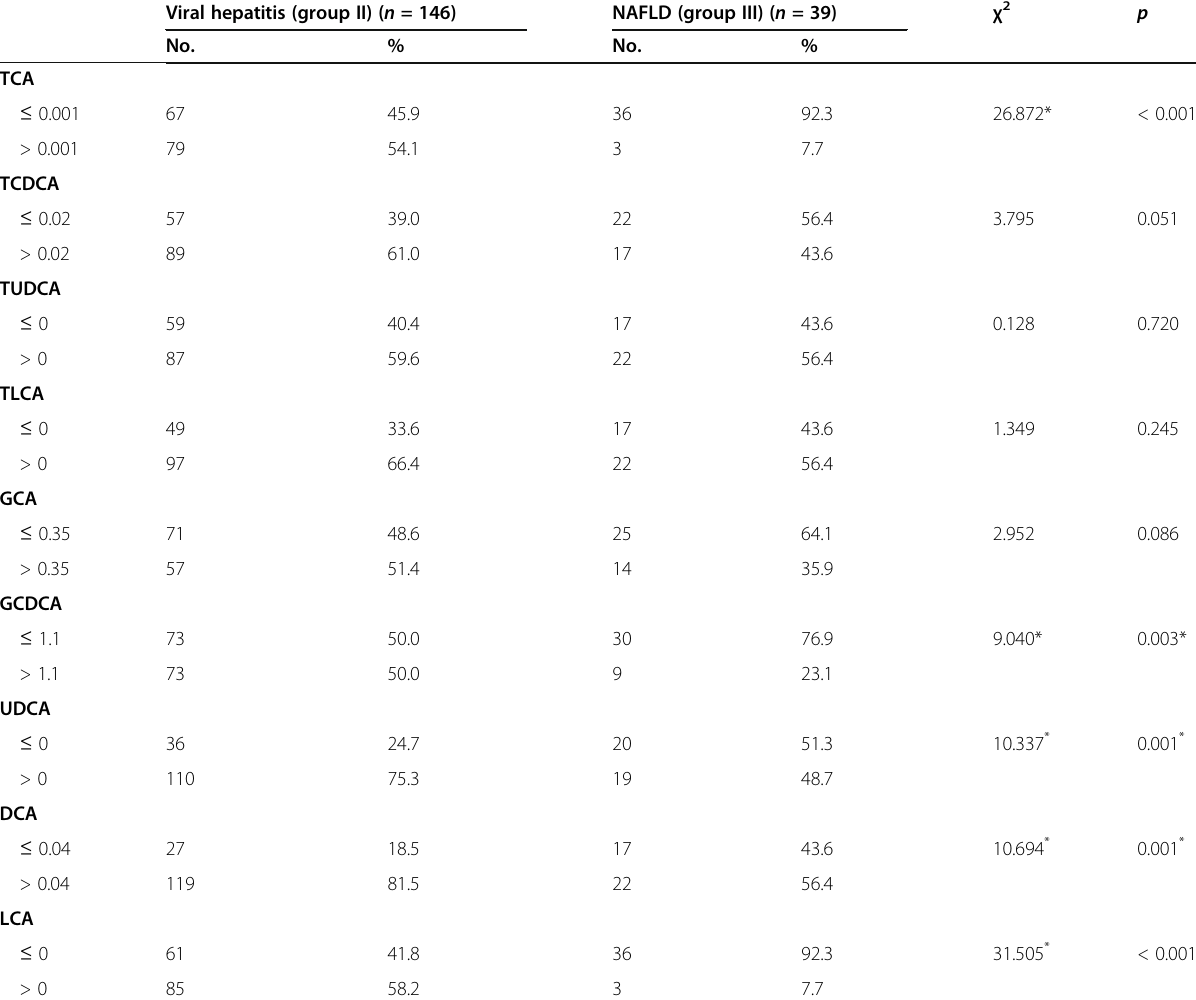
Table 5 Comparison between viral hepatitis and NAFLD groups according to the cutoff values of their bile acids Viral hepatitis (group II) ( n =